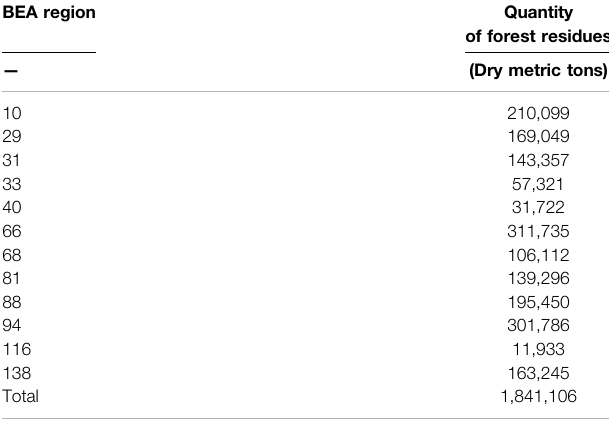
TABLE4| LocationofpotentialforestresiduesintheBEAssupplyingfeedstockto the biore fi neries. BEA